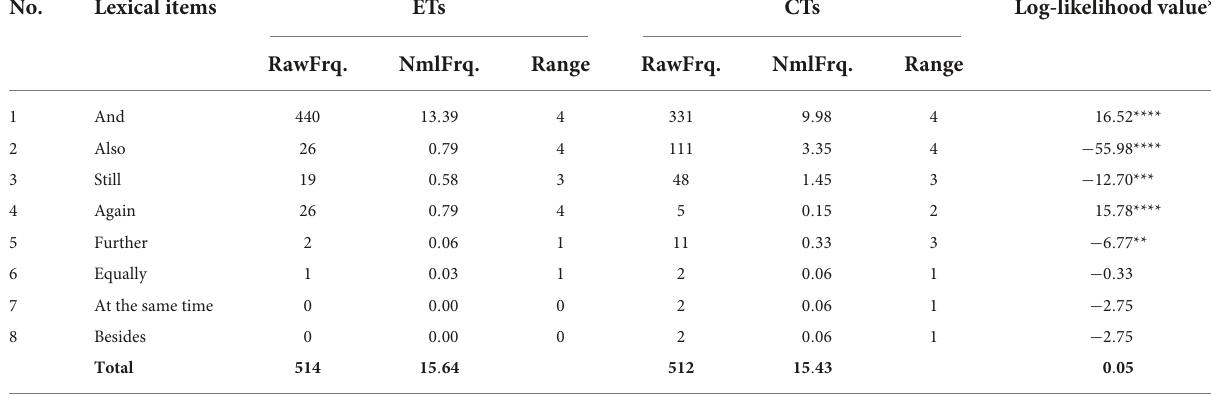
TABLE 3 Summary of additive transitions in both sub-corpora. No.